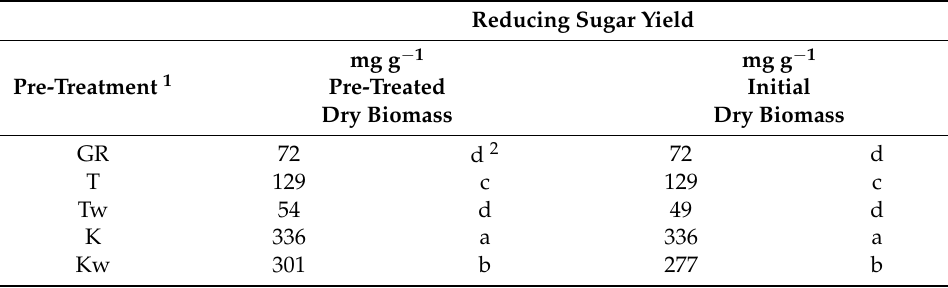
Table 2. Reducing sugar yields after enzymatic hydrolysis of differently pre-treated giant reed biomass.